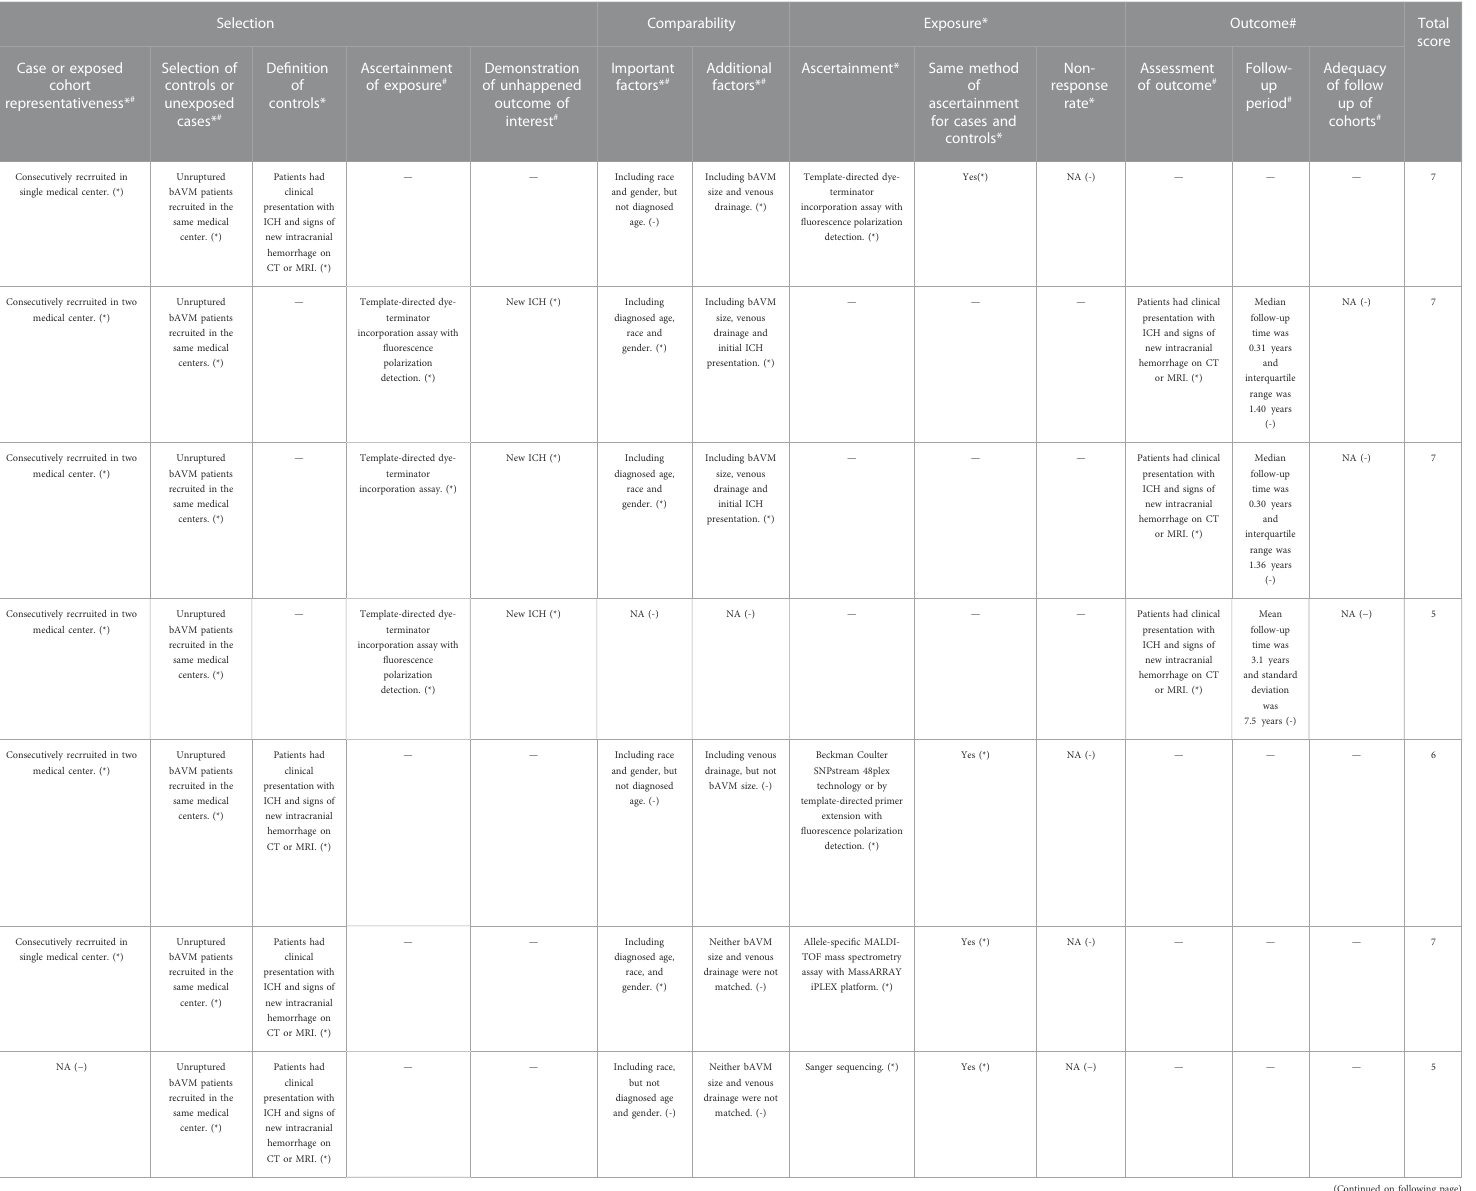
TABLE 2 Summary of the included genetic studies on brain arteriovenous malformation related hemorrhage. Author